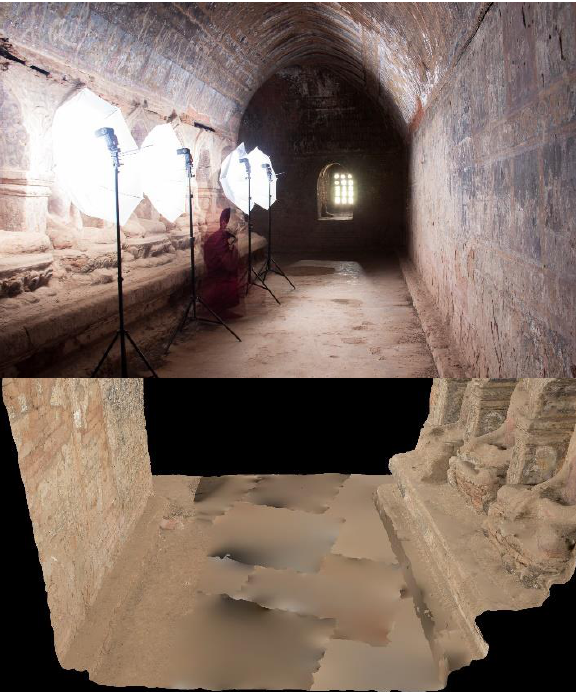
Figure 2. The photogrammetric lighting setup (top), and the missing data